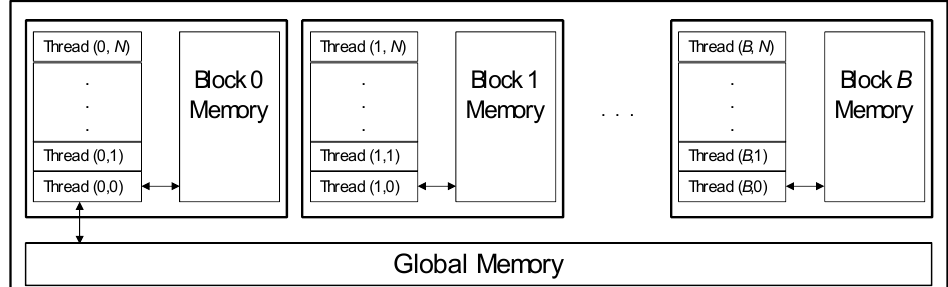
Figure 6. Subpopulation organization and memory accesses.